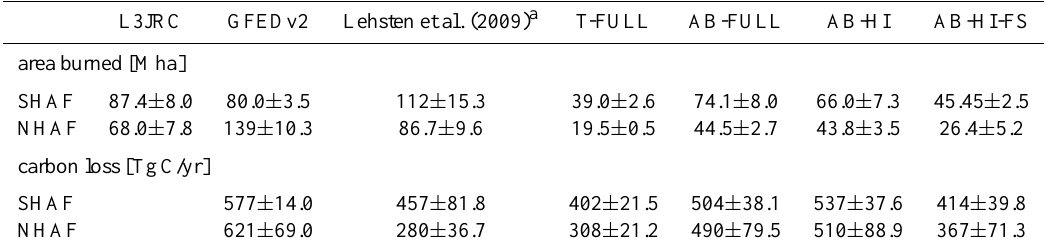
Table 2. Annual total (wildfire and deforestation) burned areas and fire carbon emissions for Africa (NHAF: Northern Hemisphere Africa, SHAF: Southern Hemisphere Africa) for the different simulations compared to observations. All reported values are averages over the years 2001–2004.